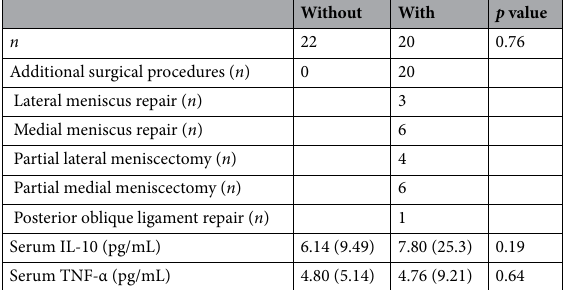
Table 2. Serum IL-10 and TNF-α concentrations with and without additional surgical procedures performed during ACL reconstructive surgery. Data presented as median (interquartile